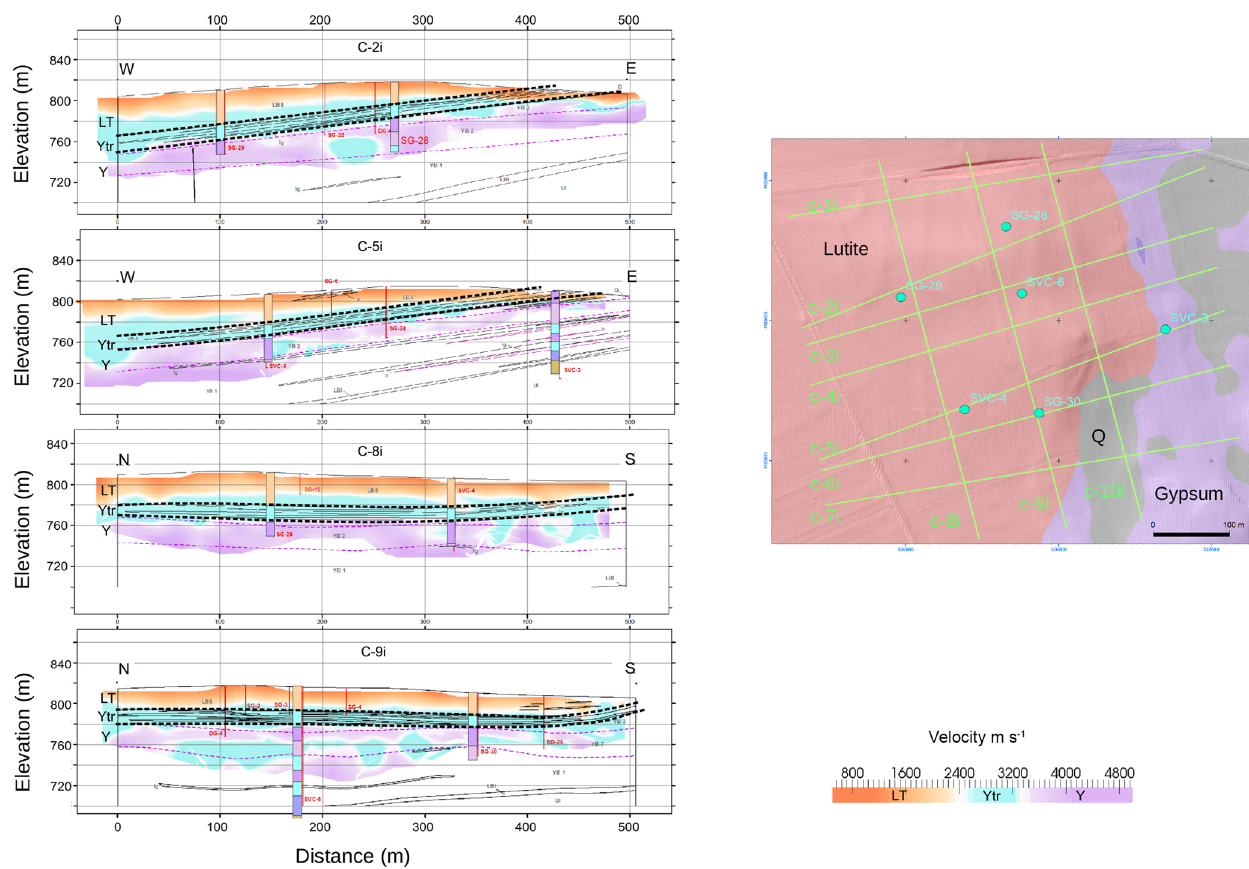
Figure 8. Resulting shallow subsurface structure represented as detailed cross sections. Cross sections integrate the velocity model derived from the tomography, the constraints provided by the boreholes and the extrapolation of surface geology data (in discontinuous drafted lines). Four different east–west and north–south cross sections are shown with their locations within the study area.